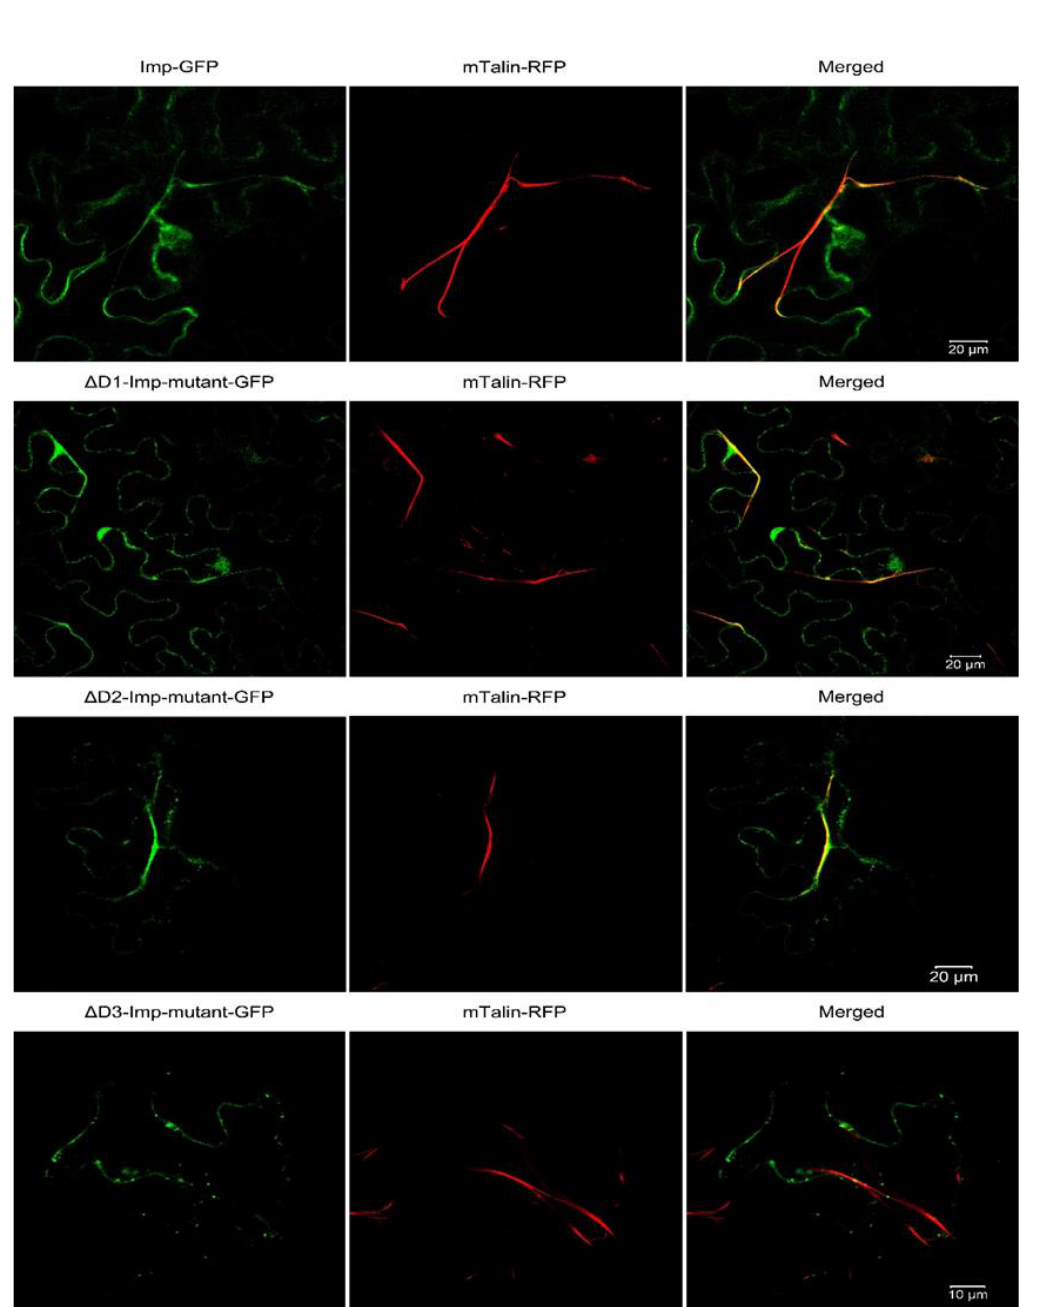
Figure 2. Co-expression of Imp-PM19, its mutants and mTalin in planta. Imp-PM19 and its mutants were fused with GFP and co-transiently expressed with mTalin fused to RFP to mark the plant actin. The localization of expressed proteins were analyzed by visualizing the infiltrated leaves mesophyll under confocal microscopy using GFP and RFP filters. The F-actin can be clearly seen as a long stretch filament (Red colour) in the middle panel. Co-localization of Imp-GFP and mTalin-Red is indicated by yellow colouring in the merger. A magnification of Figure 2 can be seen in Supplement Figure S1.